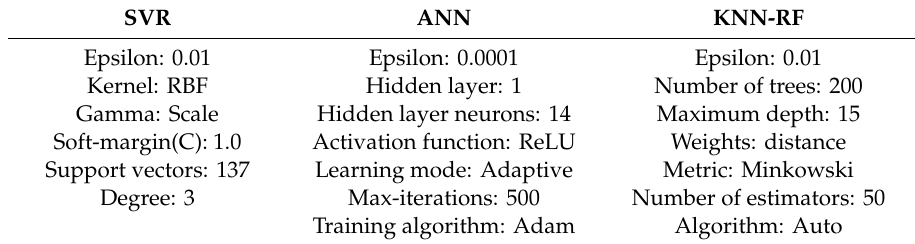
Table 4. Summary of the selected parameters during training of the SVR, ANN, and KNN-RF